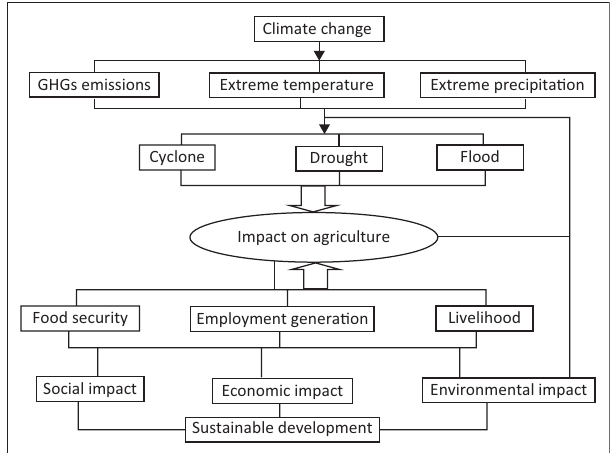
FIGURE 5: Conceptualisation of implication of climate change on sustainable development (greenhouse